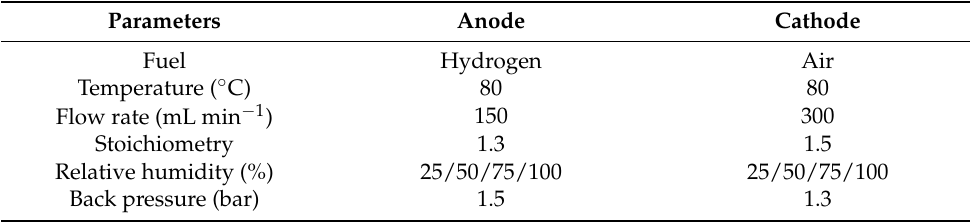
Table 1. MEA test conditions in the PEMFC single